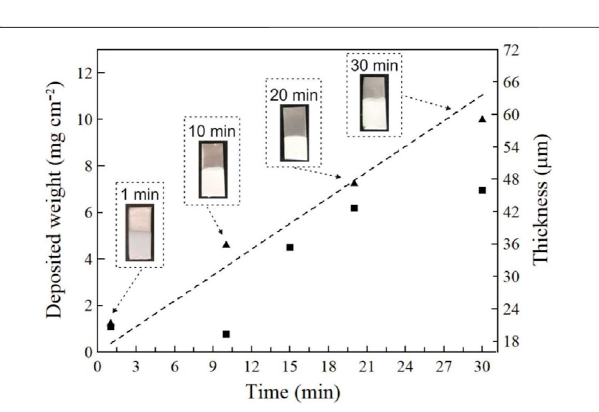
FIGURE6| ( ■ )Thicknessand( ▲ )depositedweightofcoatingsobtained by EPD procedures.